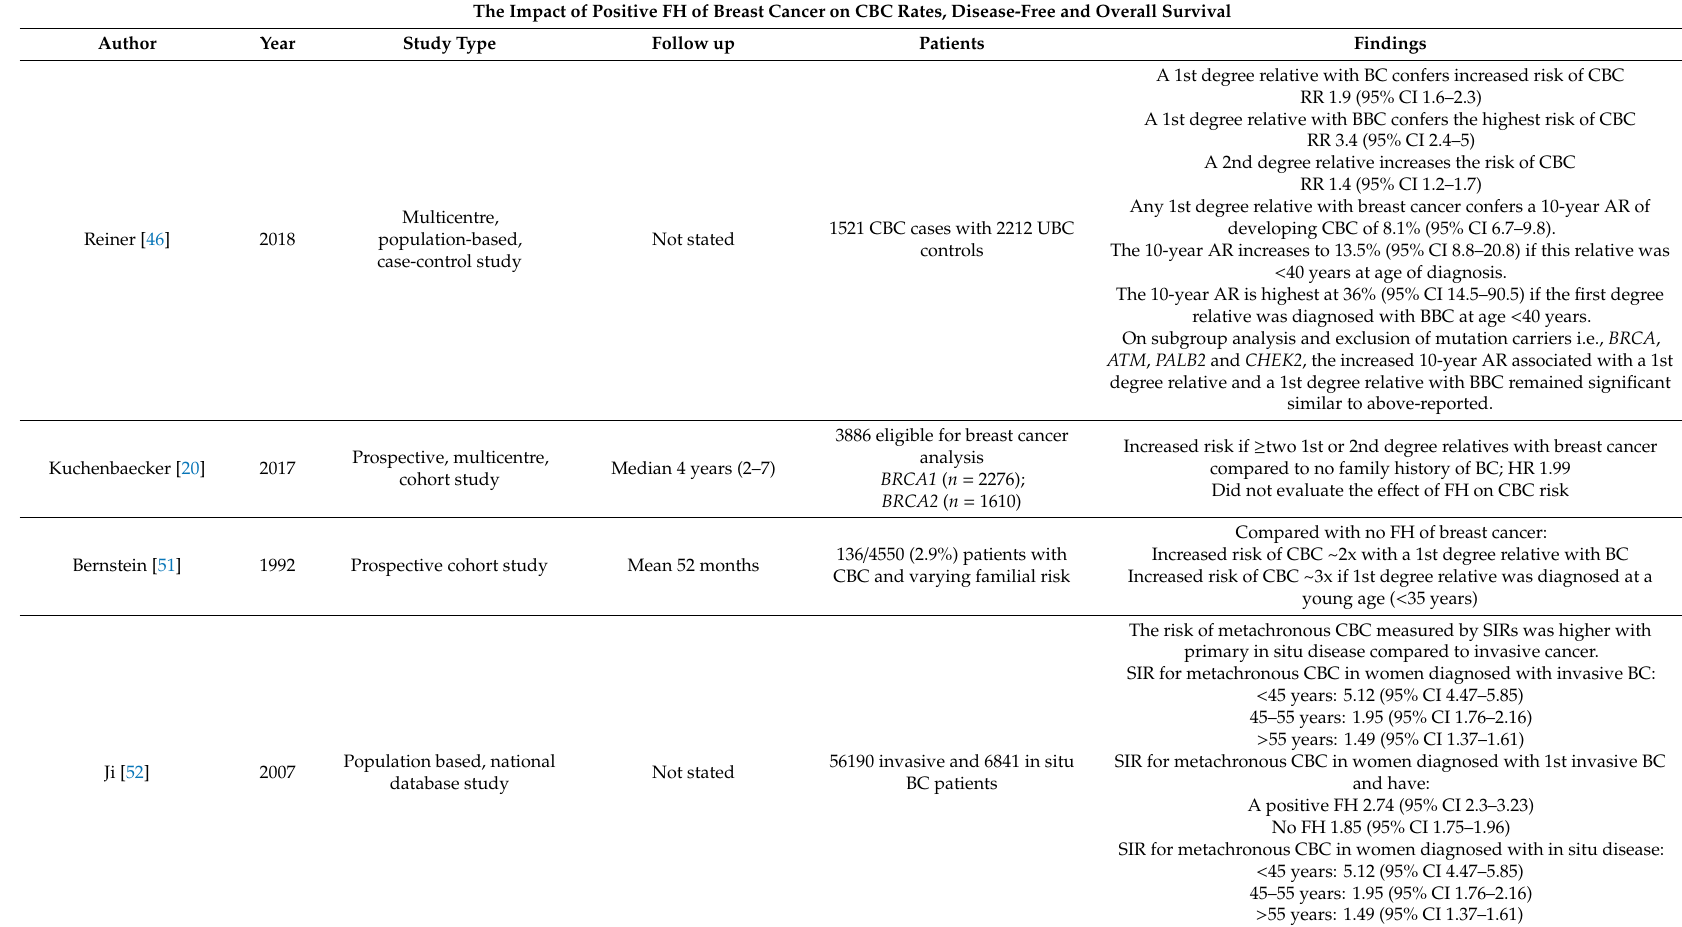
Table 3. Studies looking at the impact of positive FH of breast cancer on CBC rates, disease-free and overall survival. The Impact of Positive FH of Breast Cancer on CBC Rates, Disease-Free and Overall